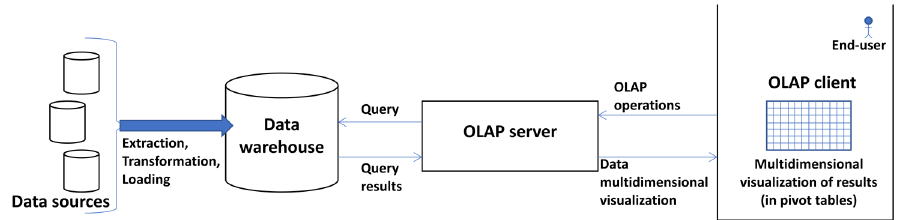
Figure 6. OLAP Figure 6. OLAP architecture.